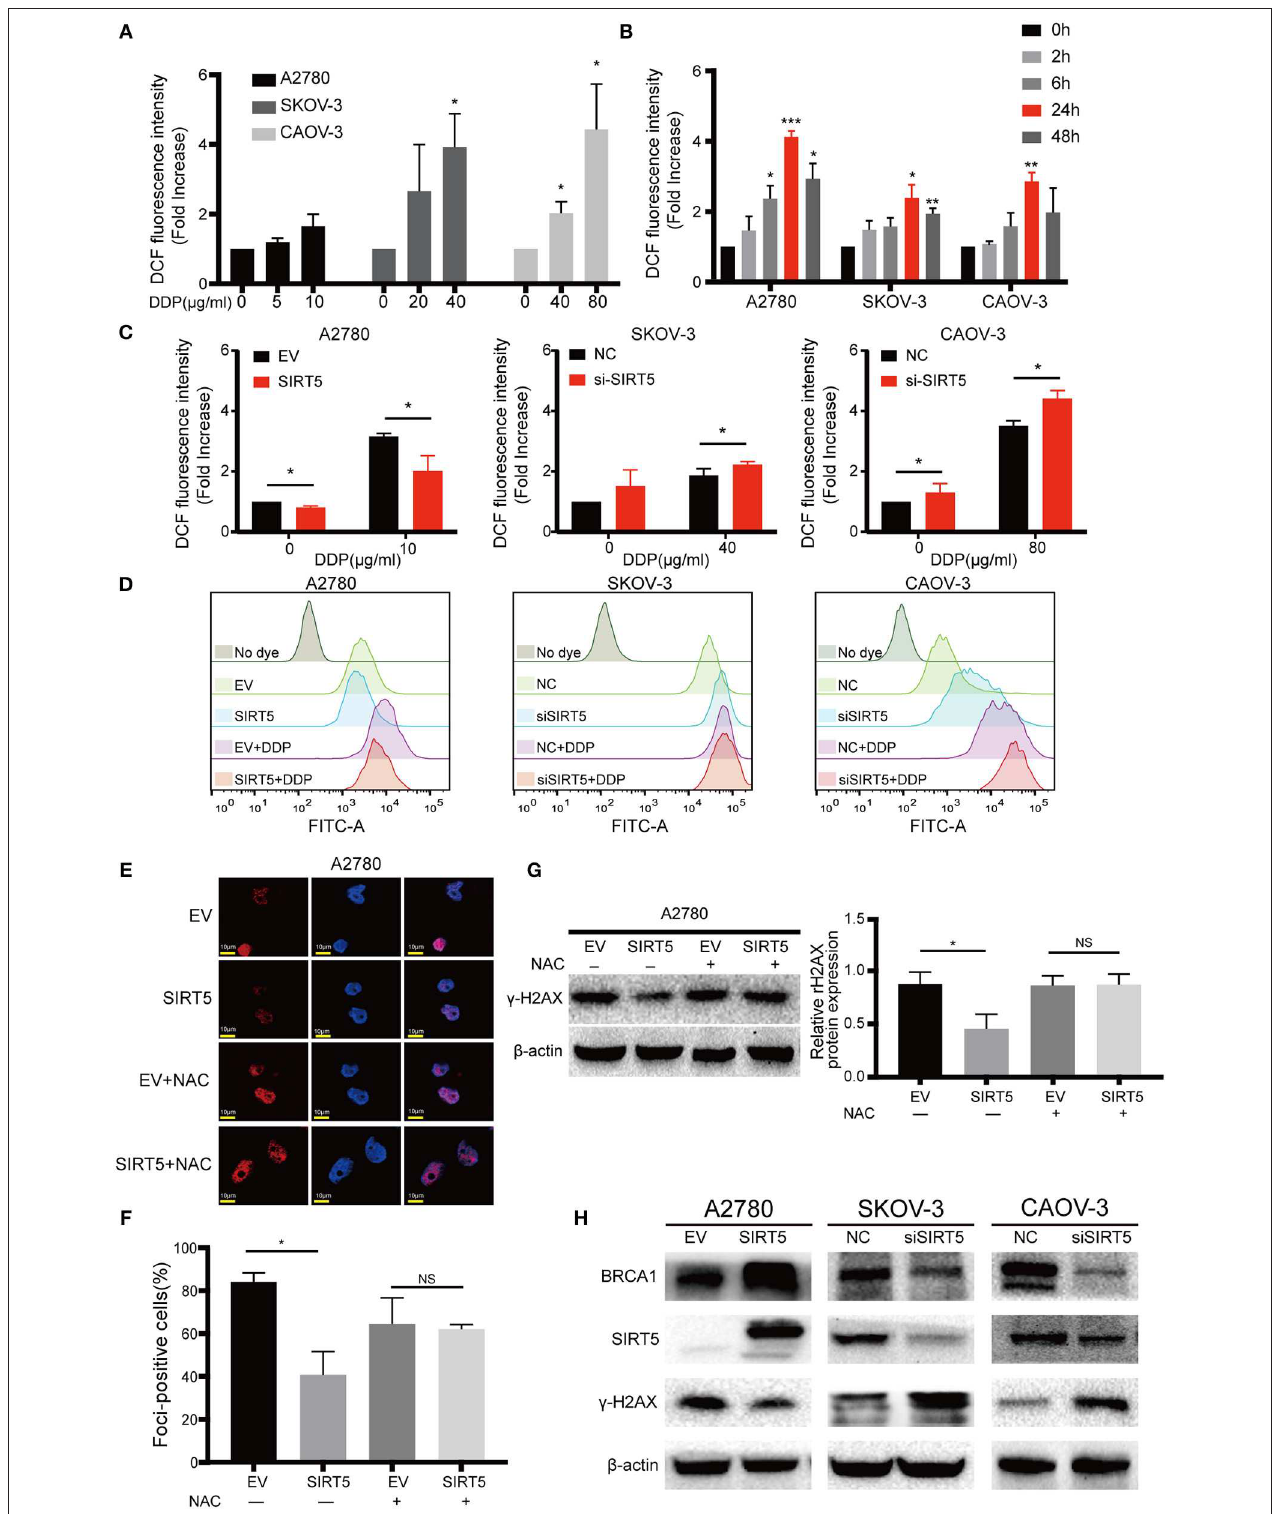
FIGURE 5 | SIRT5 eliminates cisplatin induced ROS to reduce DNA damage. (A) Cisplatin induced ROS generation in concentration and (B) time dependent manner in three ovarian cancer cells. The cells were treated with indicated dose of cisplatin and collected at indicated time points. The ROS levels were measured by flow